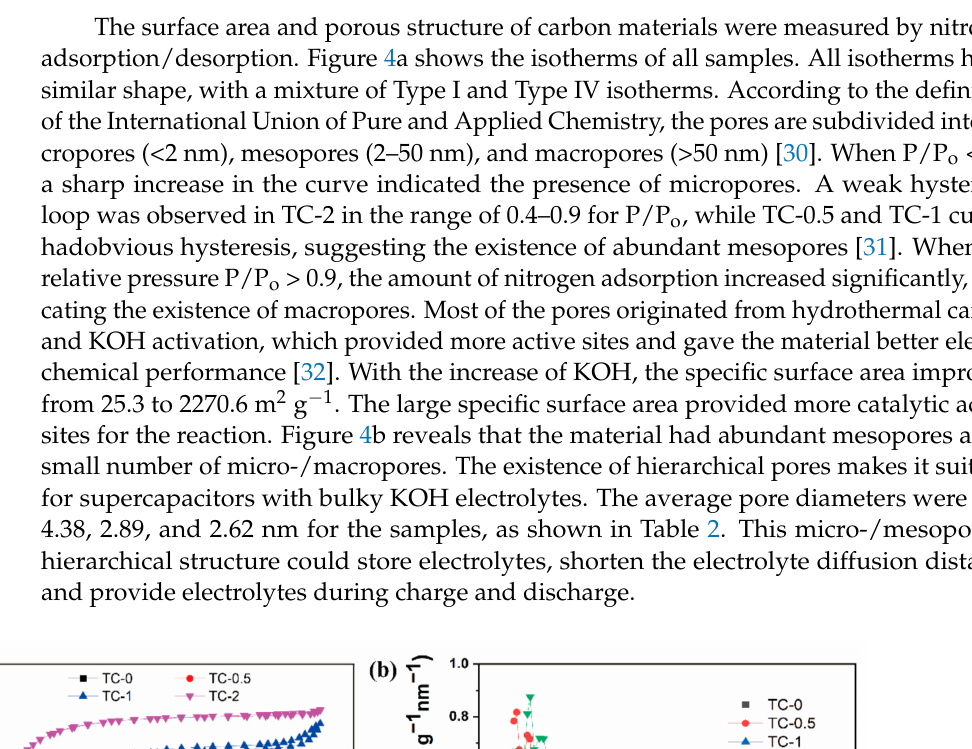
Figure 3. TEM images of TC-1 at ( a ) low magnification and ( b ) high magnification.